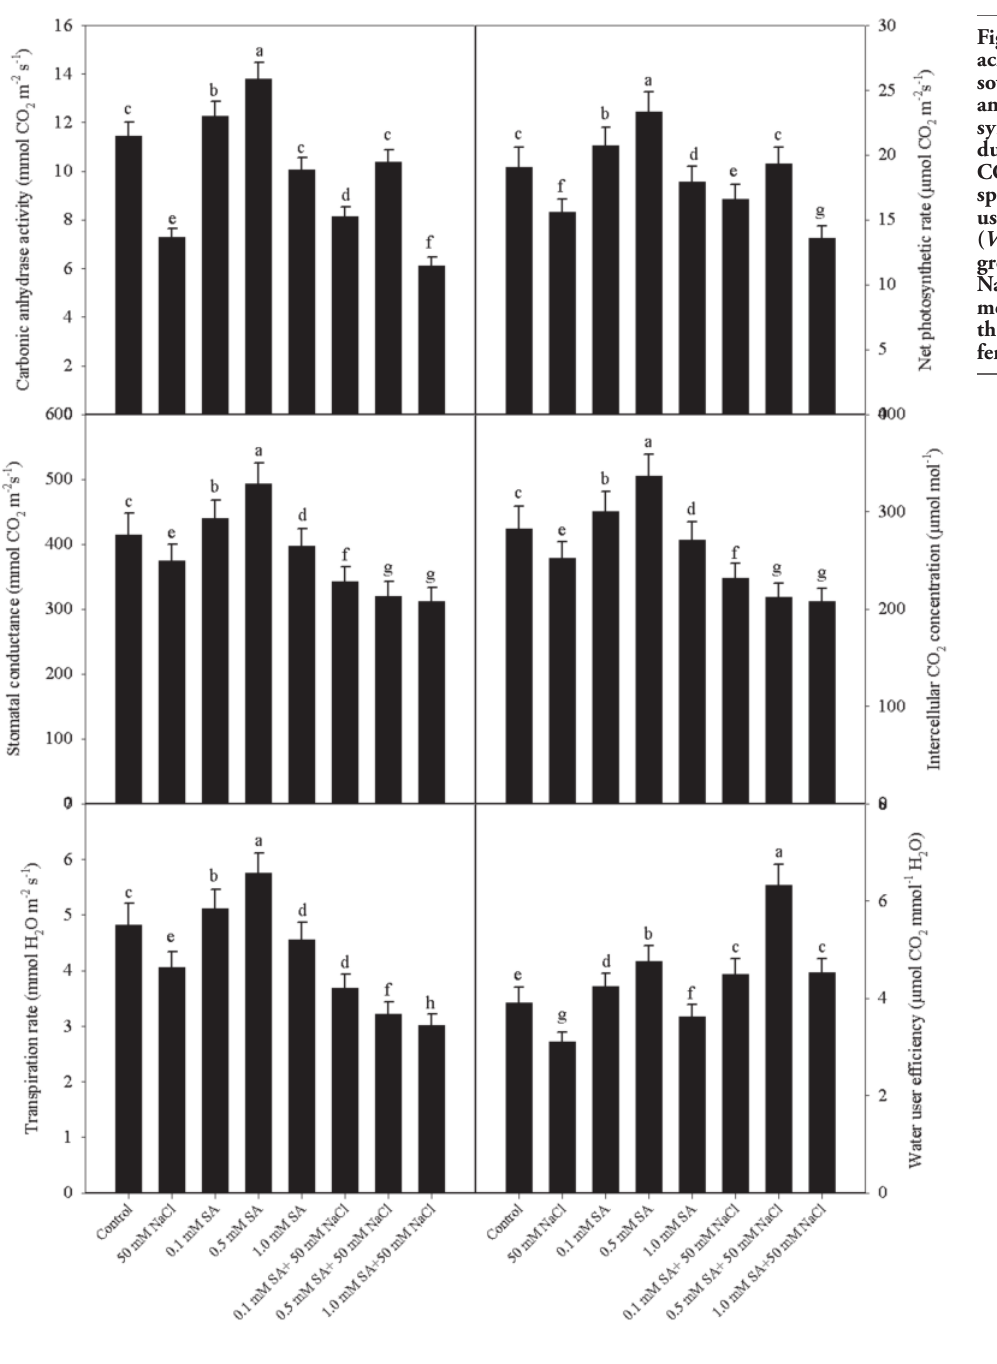
Figure 6. Effect of salicylic acid spray at 15 days after sowing (DAS) on carbonic anhydrase activity, photo- synthesis, stomatal con- ductance, intercellular CO 2 concentration, tran- spiration rate, and water use efficiency of mungbean ( Vigna radiata L.) plants grown with 0 or 50 mM NaCl at 30 DAS. Values are mean±SE. Data labeled by the same letter did not dif- fer significantly at